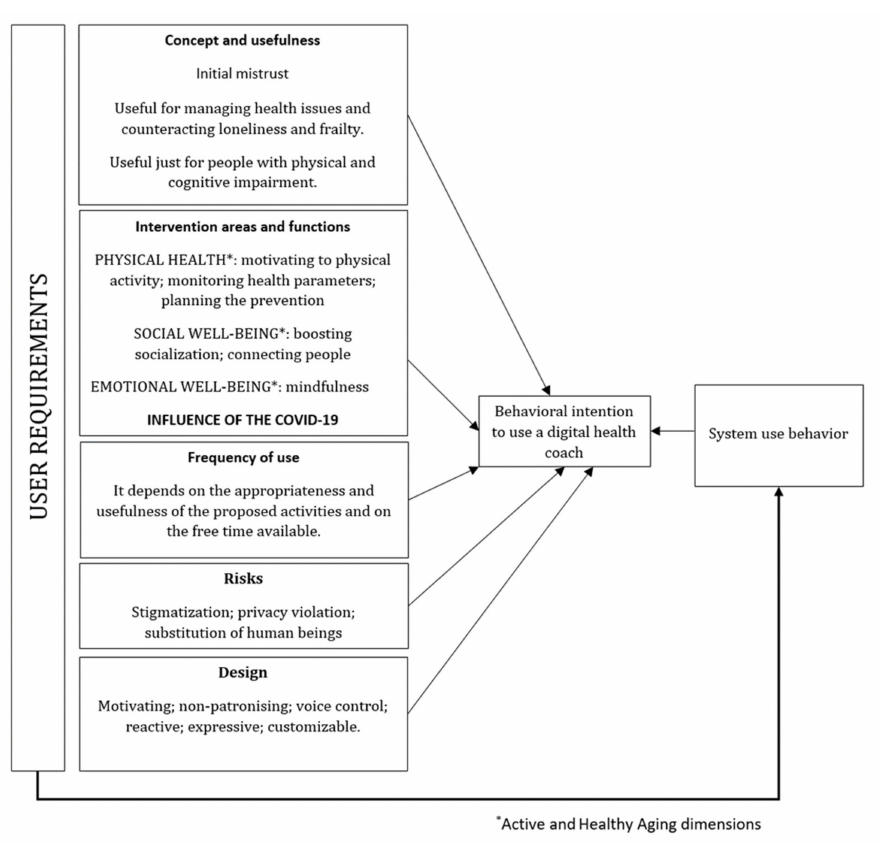
Figure 3. Determinants of behavioral intentions and use behaviors of a VC. Table 3. User requirements: main themes and codes from the focus-groups and the telephone follow-up interviews by country, answering the two Research Questions